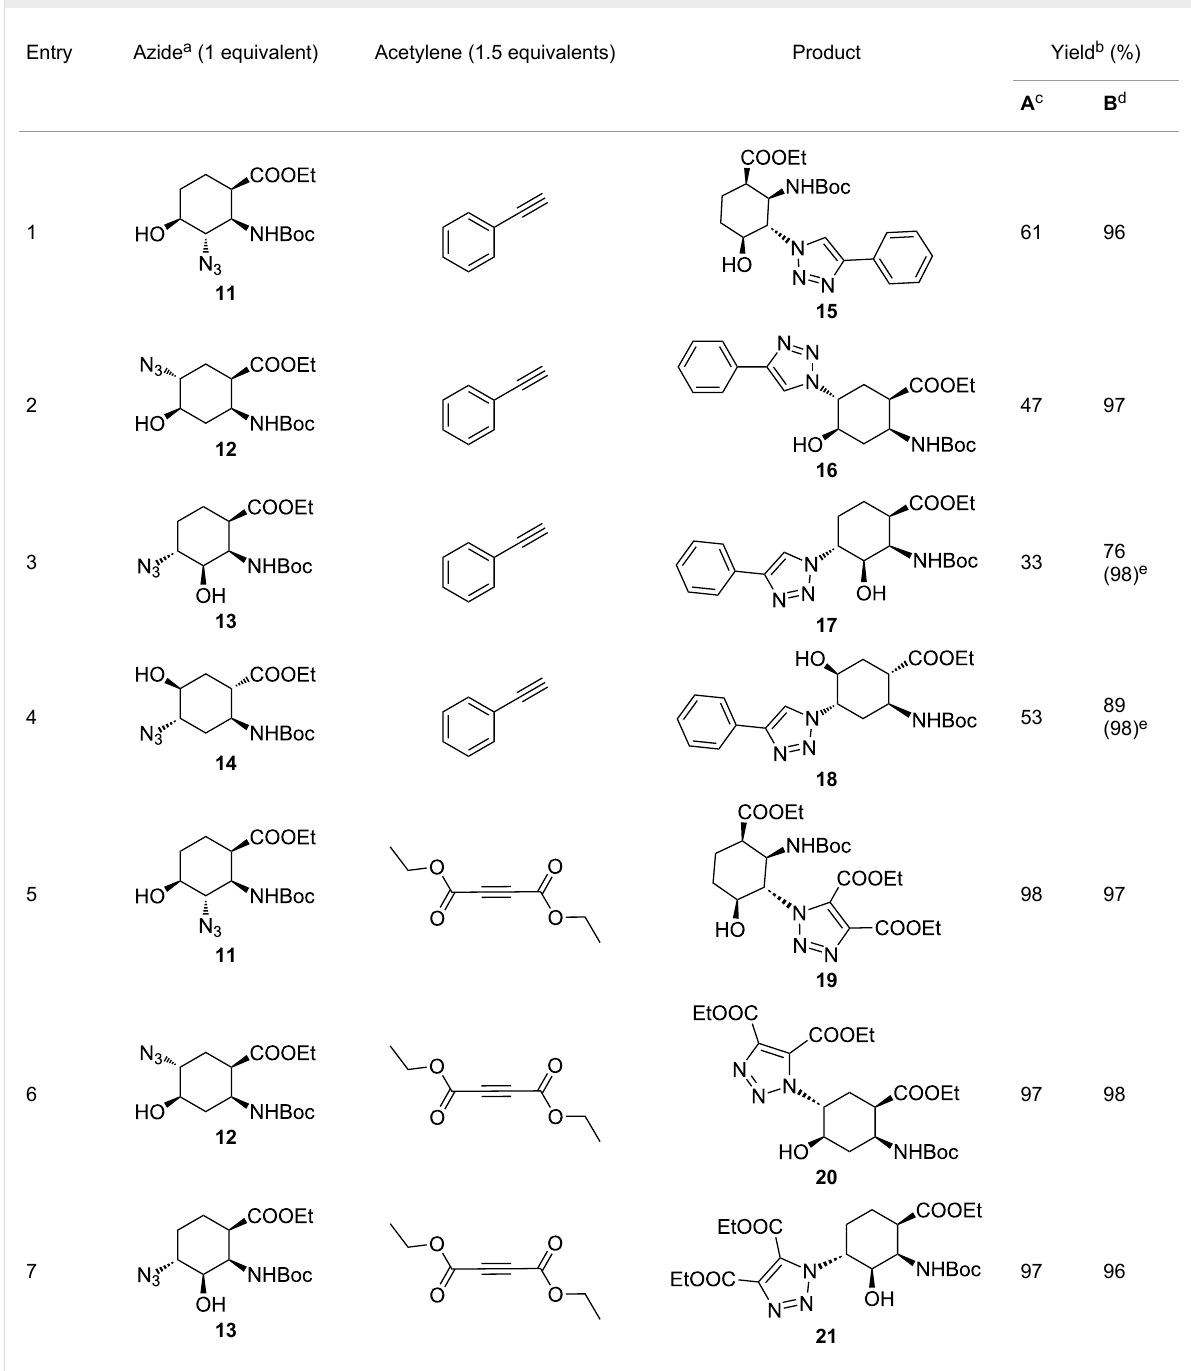
Table 1: CF synthesis of 1,2,3-triazole-substituted alicyclic β -amino acid